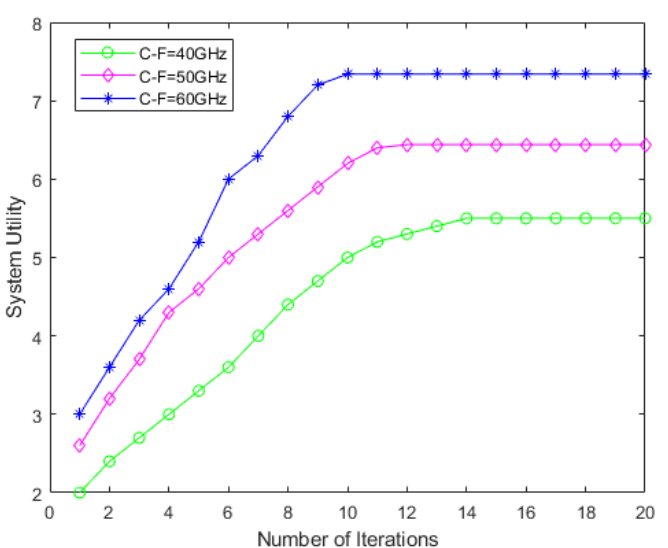
Figure 6. Impact of cloud resources.